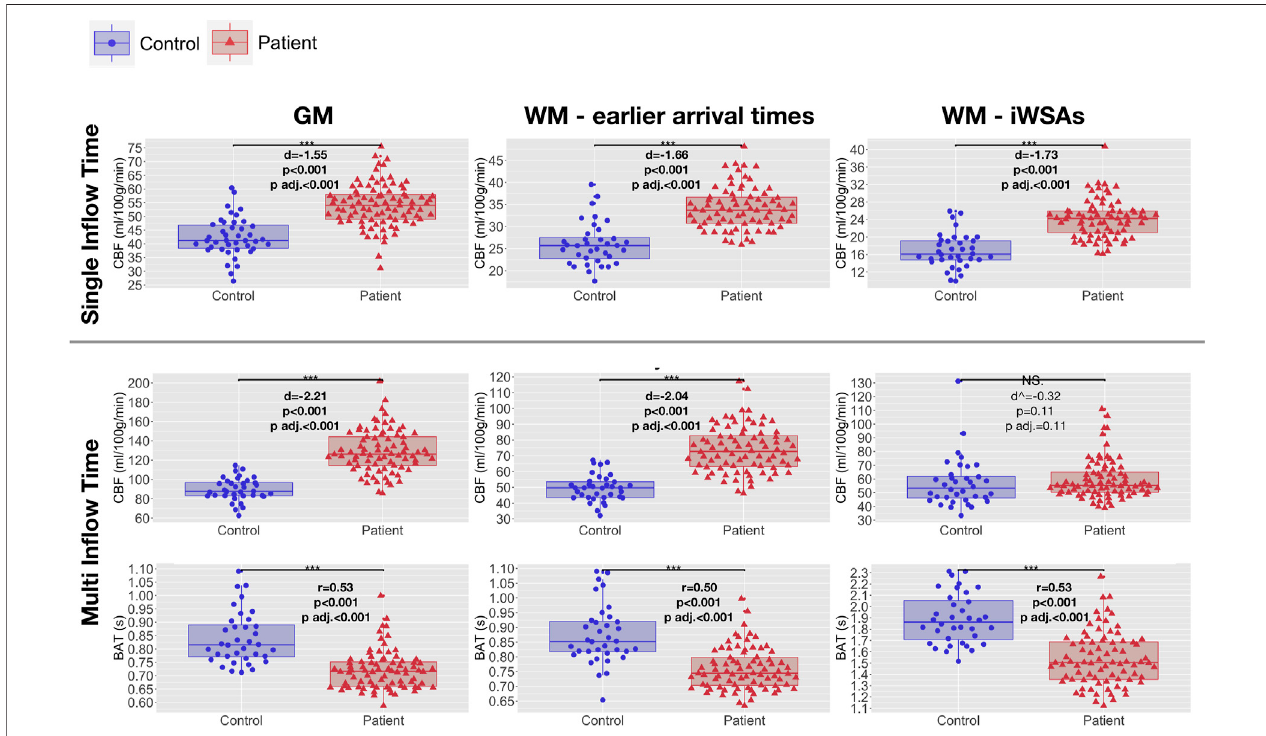
FIGURE 5 | Hemodynamic parameters across regions of interest. Boxplots showing mean cerebral blood fl ow (CBF) and bolus arrival times (BAT) based on the single- and multi-in fl ow time sequences (rows) across different regions of interest (ROIs; columns) in patients with sickle cell anemia (shown in red) and healthy controls (shown in blue). Standardized mean differences (d) and probability values from independent t-tests (p) adjusted within parameter types for multiple comparisons using theBenjaminiandHochbergfalsediscoveryrate(padj.)aredisplayed.^between-groupdifferencesiniWSACBFreportedwithoutlyingcontrolexcluded.Between group differences remain non-signi fi cant when the outlier is included ( p = 0.51). Abbreviations: GM, gray matter; WM, white matter; iWSAs, individual watershed